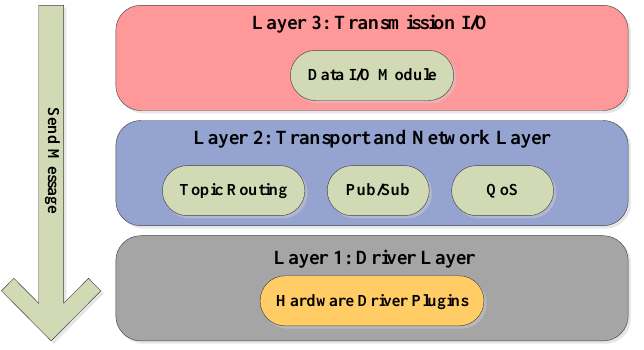
Figure 3. CoHoN architecture, as decribed in [29].